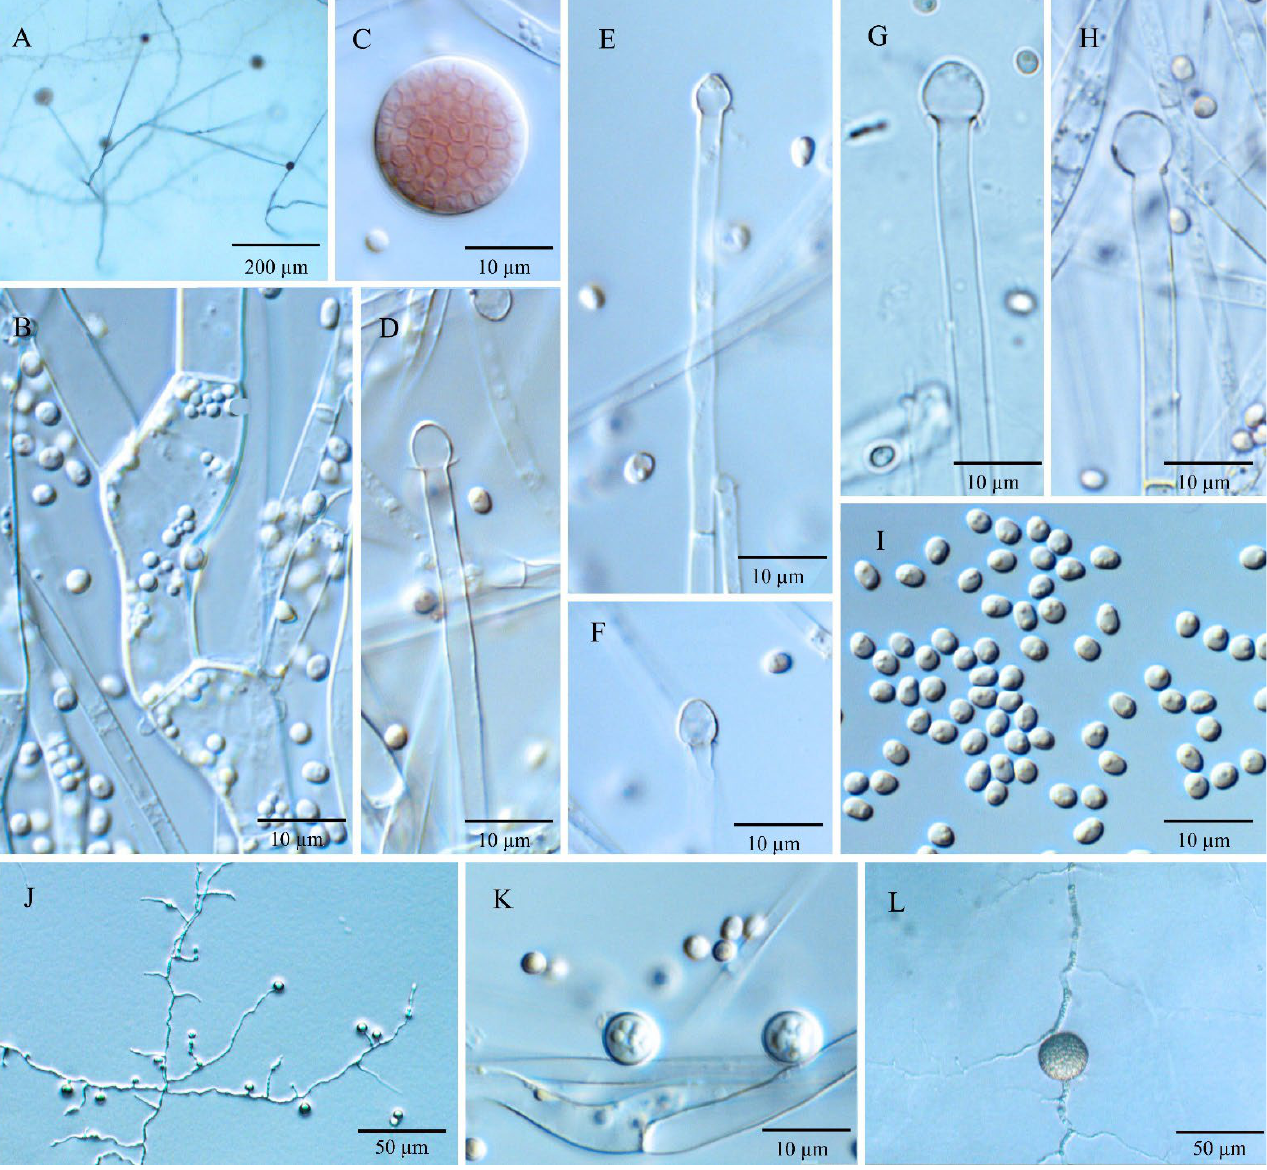
Figure 3. Umbelopsis dura . ( A ) The main branching pattern of sporangiophore. ( B ) Branch point of sporangiophore. ( C ) Sporangium at tip of sporangiophore. ( D – H ) Various shapes of collars and columellae at sporangiophore tips after the sporangia have been dissolved. ( I ) Sporangiospores. ( J , K ) Micro-chlamydospores. ( L ) Macro-chlamydospore. Description: Colonies on MEA reaching 50–52 mm in diam. after 10 days at 18 °C, 1 mm high, velvety, zonate, not wrinkled, sometimes forming sectors, at first white, then